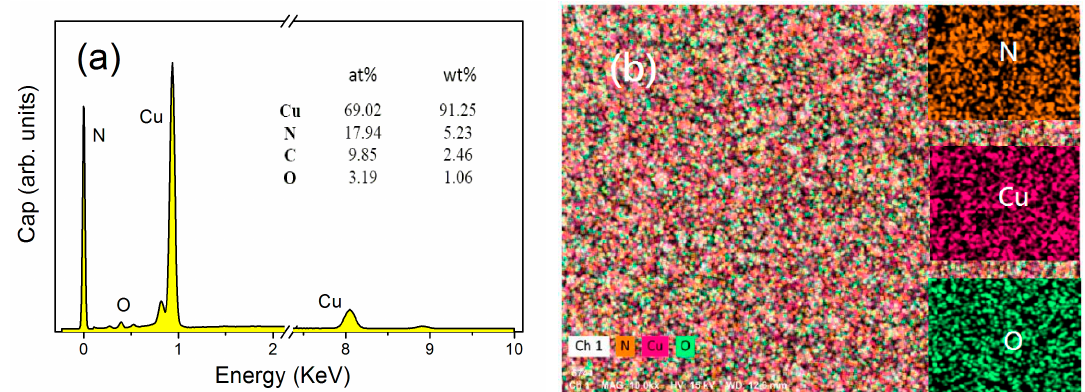
Figure 2. ( a ) Energy disperse spectra (EDS) results of Cu 3 N films prepared at r = 1 / 3, and the inserted value are the atomic and mass percentages of various atoms in the Cu 3 N films; ( b ) corresponding EDS elemental mapping of the surface of the Cu 3 N films.